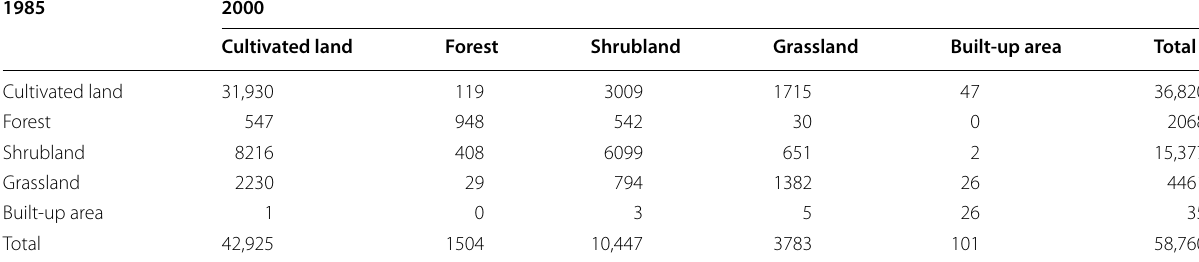
Table 7 Transition area matrix (ha) between 1985 and 2000 periods in the Andassa watershed 1985